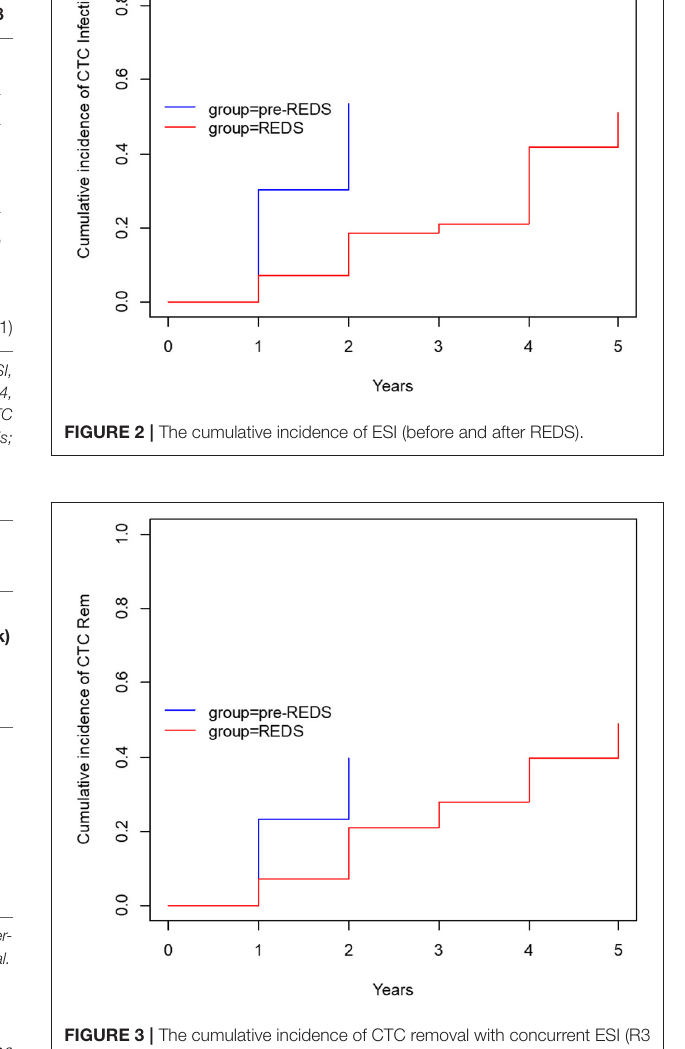
TABLE 2 | Incidence of CTC-related infectious complications in pre-REDS and REDS period of time. Pre-REDS